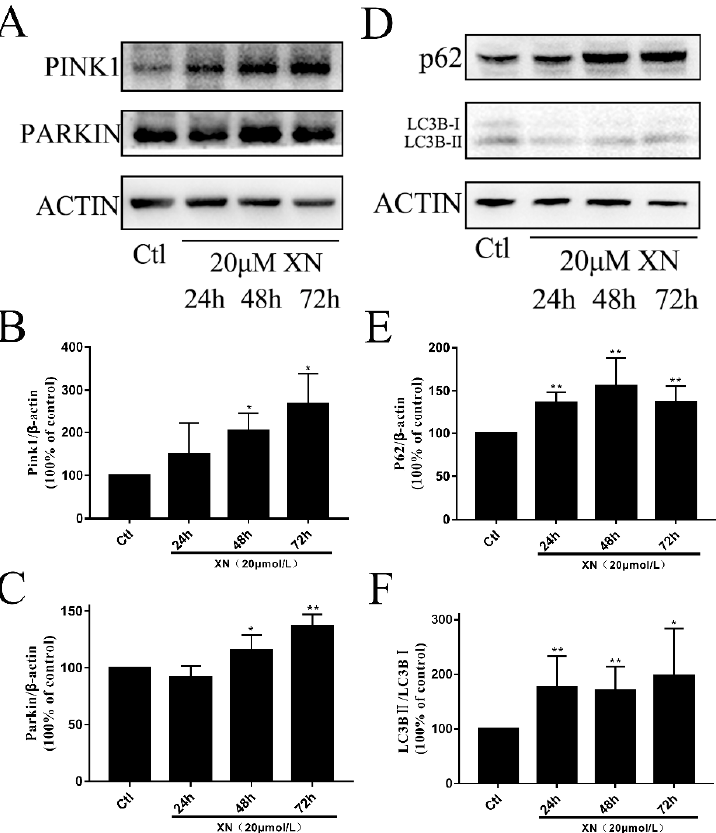
Figure 9. XN (20 uM)-induced mitophagy in C6 cells. ( A – C ) Cells were treated with XN for 24, 48, and 72 h, and then protein expression of PINK1, PARKIN was determined by Western blot analysis. ( D – F ) Cells were treated with XN for 24, 48, and 72 h, and then protein expression of LC3B, and p62 was determined by Western blot analysis. All data presented are the mean ± SEM from three independent experiments. * p < 0.05, ** p < 0.01 vs. control groups.